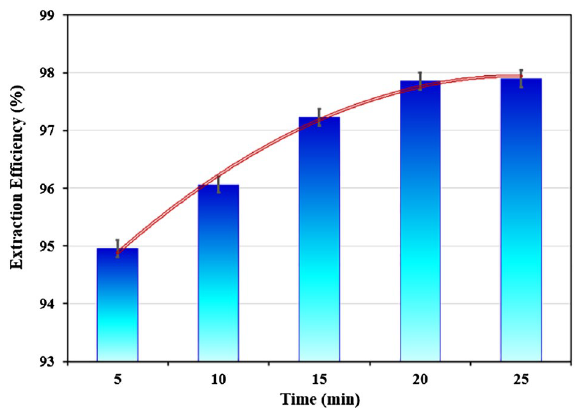
Figure 8. Effect of time on the extraction of Co(II) (T = 25 °C, Co(II) = 500 ppm, PEG = 50% w/w, (NH 4 ) 2 SO 4 = 4 M, pH = 2).